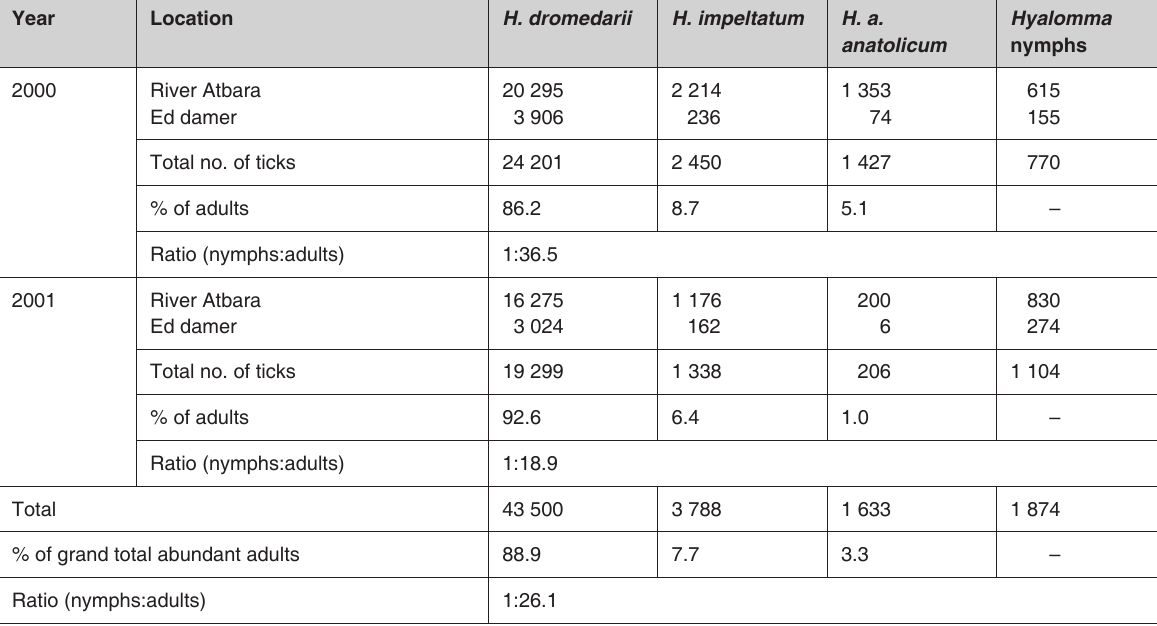
TABLE 2 Total tick burdens on camels in River Nile State, Northern Sudan, 2000 and 2001